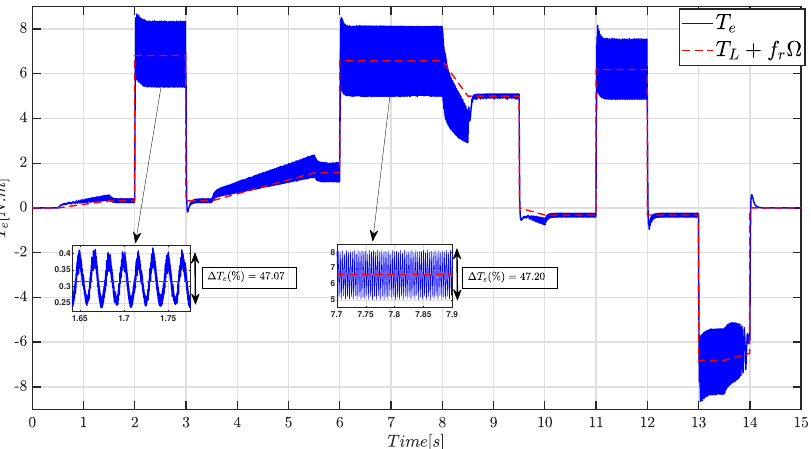
Figure 11. Torque response obtained by PI controllers and maximum torque per ampere method.